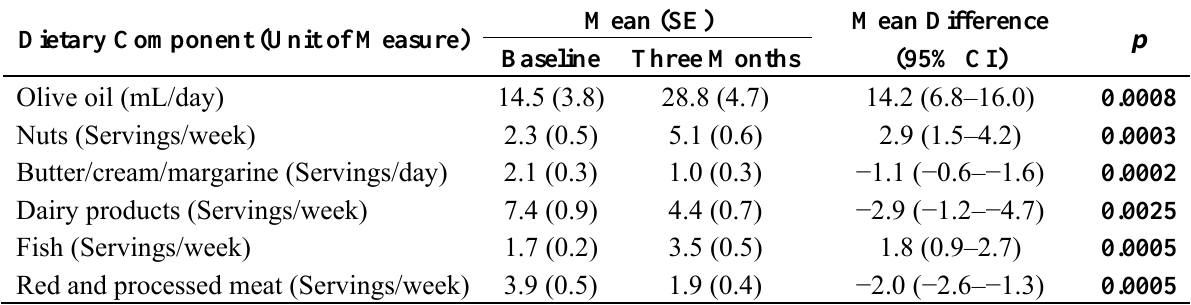
Table 2. Changes in the sources of dietary fat from baseline to three months. Dietary Component (Unit of Measure)